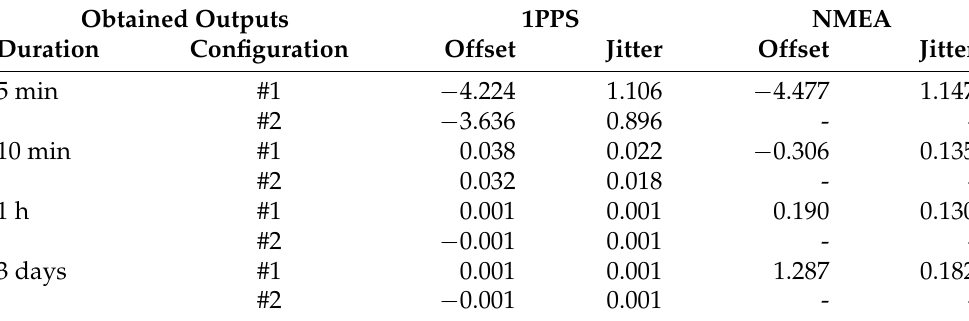
Table 1. Obtained time offset and jitter values (in ms) in different